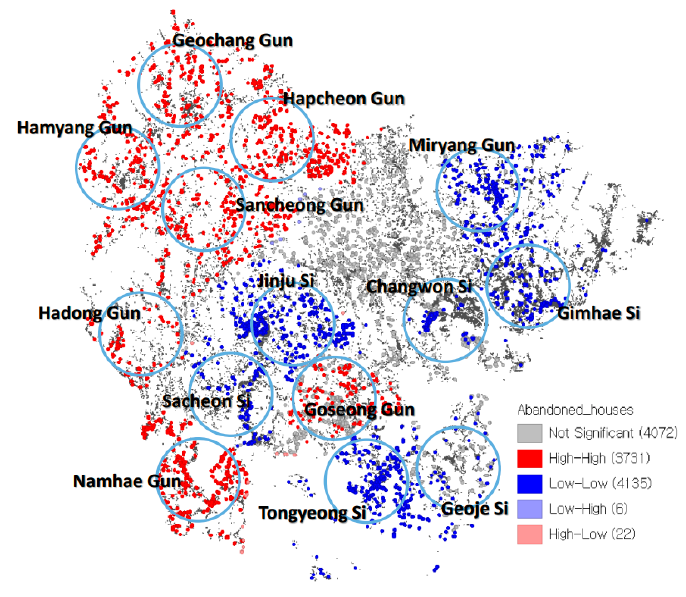
Figure 8. LISA cluster map.